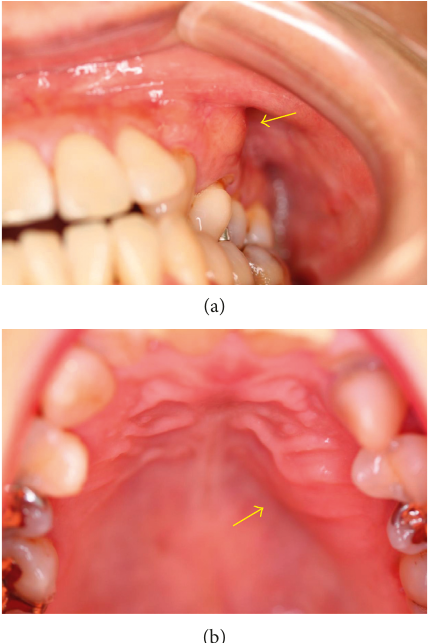
Figure 1: Intraoral appearance of the upper jaw. (a, b) Swollen nonulcerative mucosa in the buccal and palatal side gingiva (yellow arrow).